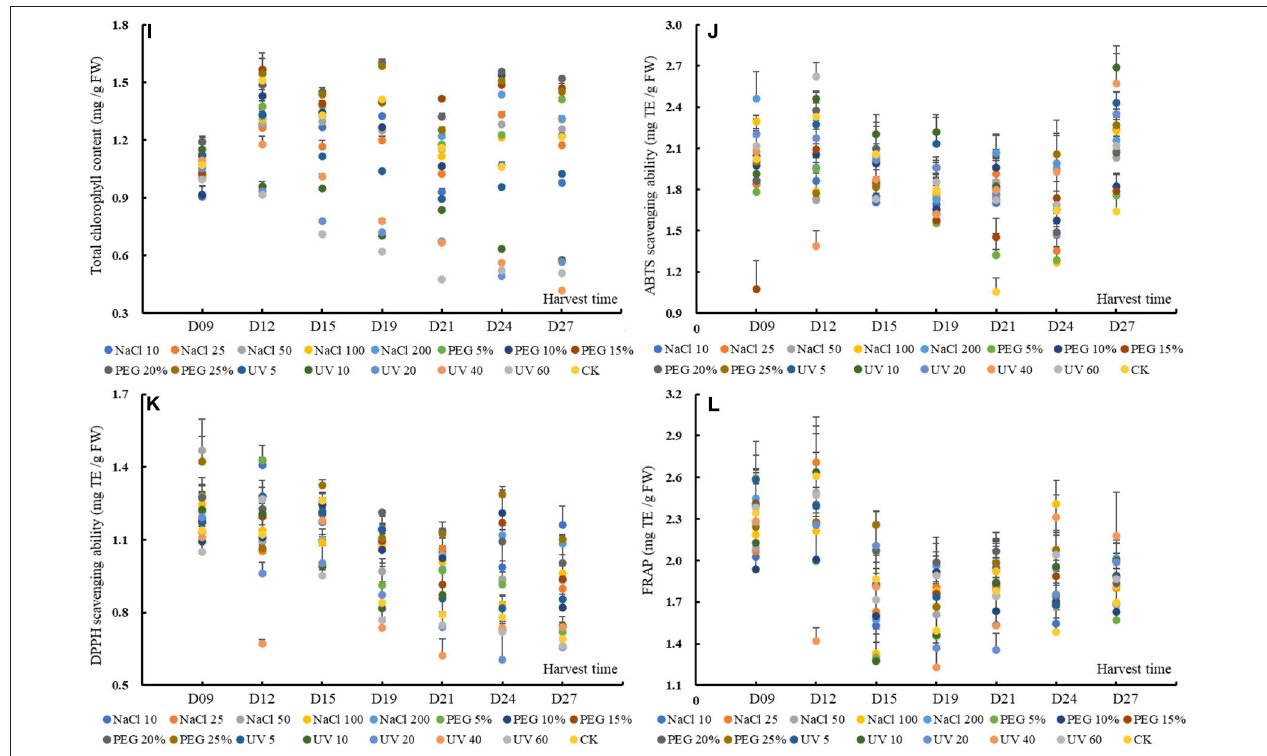
FIGURE 1 | The content or value of total triterpenes (A) , total polyphenols (B) , total flavonoids (C) , total proanthocyanins (D) , total soluble polysaccharides (E) , ascorbic acid (F) , chlorophyll a (G) , chlorophyll b (H) and total chlorophyll (I) , 2,2’-azino-bis (3-ethylbenzthia- zoline-6-sulfonic acid) (ABTS) (J) , and 2,2-diphenyl-1-picrylhydrazyl (DPPH) (K) scavenging ability and ferric iron-reducing antioxidant power (L) of wheatgrass on the 9th ∼ 27th day after seed sowing. A total of 112 samples (16 groups × 7 times of harvesting) were analyzed. The results were expressed as mean ±